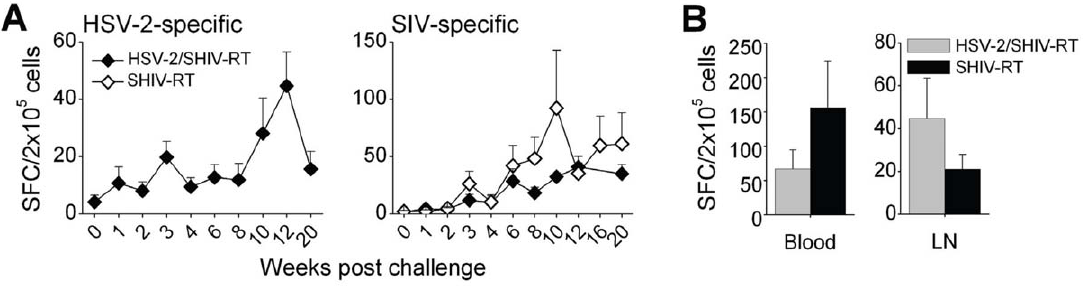
Figure 4. HSV-2 infection induces adaptive immunity and does not impede SIV-specific adaptive responses. (A) HSV-2- and SIV-specific T-cell responses were monitored over time by IFN- c ELISPOT and the data are expressed as the mean ( 6 SEM) HSV-2- (left panel) or SIV-specific (right panel) spot-forming cells (SFC) per 2 6 10 5 PBMCs. (HSV-2/SHIV-RT co-infected closed symbols, n=8; SHIV-RT-infected open symbols, n=10). (B) The mean ( 6 SEM) numbers of SIV-specific SFC per 2 6 10 5 cells are plotted for the blood (left panel) and for the LNs (right panel) collected upon euthanization of HSV-2/SHIV-RT co-infected animals (n=8, 10–13 months post co-challenge) vs animals only infected with SHIV-RT (n=3, 10–12 months post challenge).